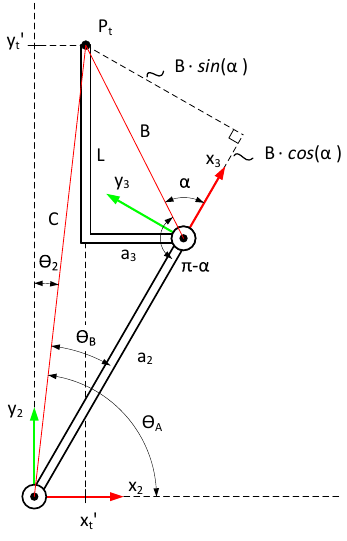
Figure 14: Geometric approach for shoulder joint θ 2 . Line B remains constant for all configurations and is defined as: